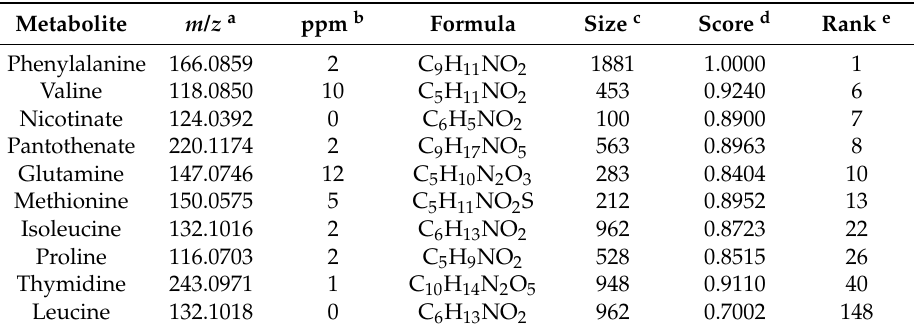
Table 1. MS 2 results for ten commonly known metabolites.